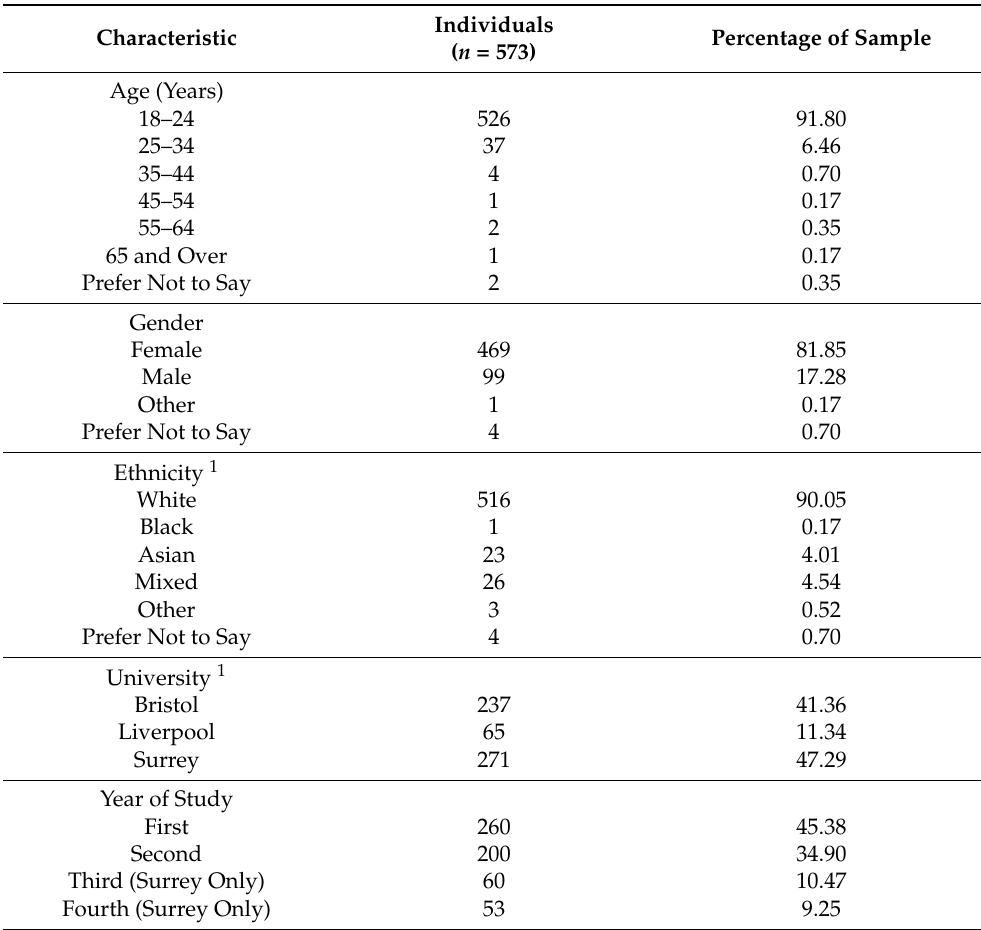
Table 1. Demographic details for whole student sample.